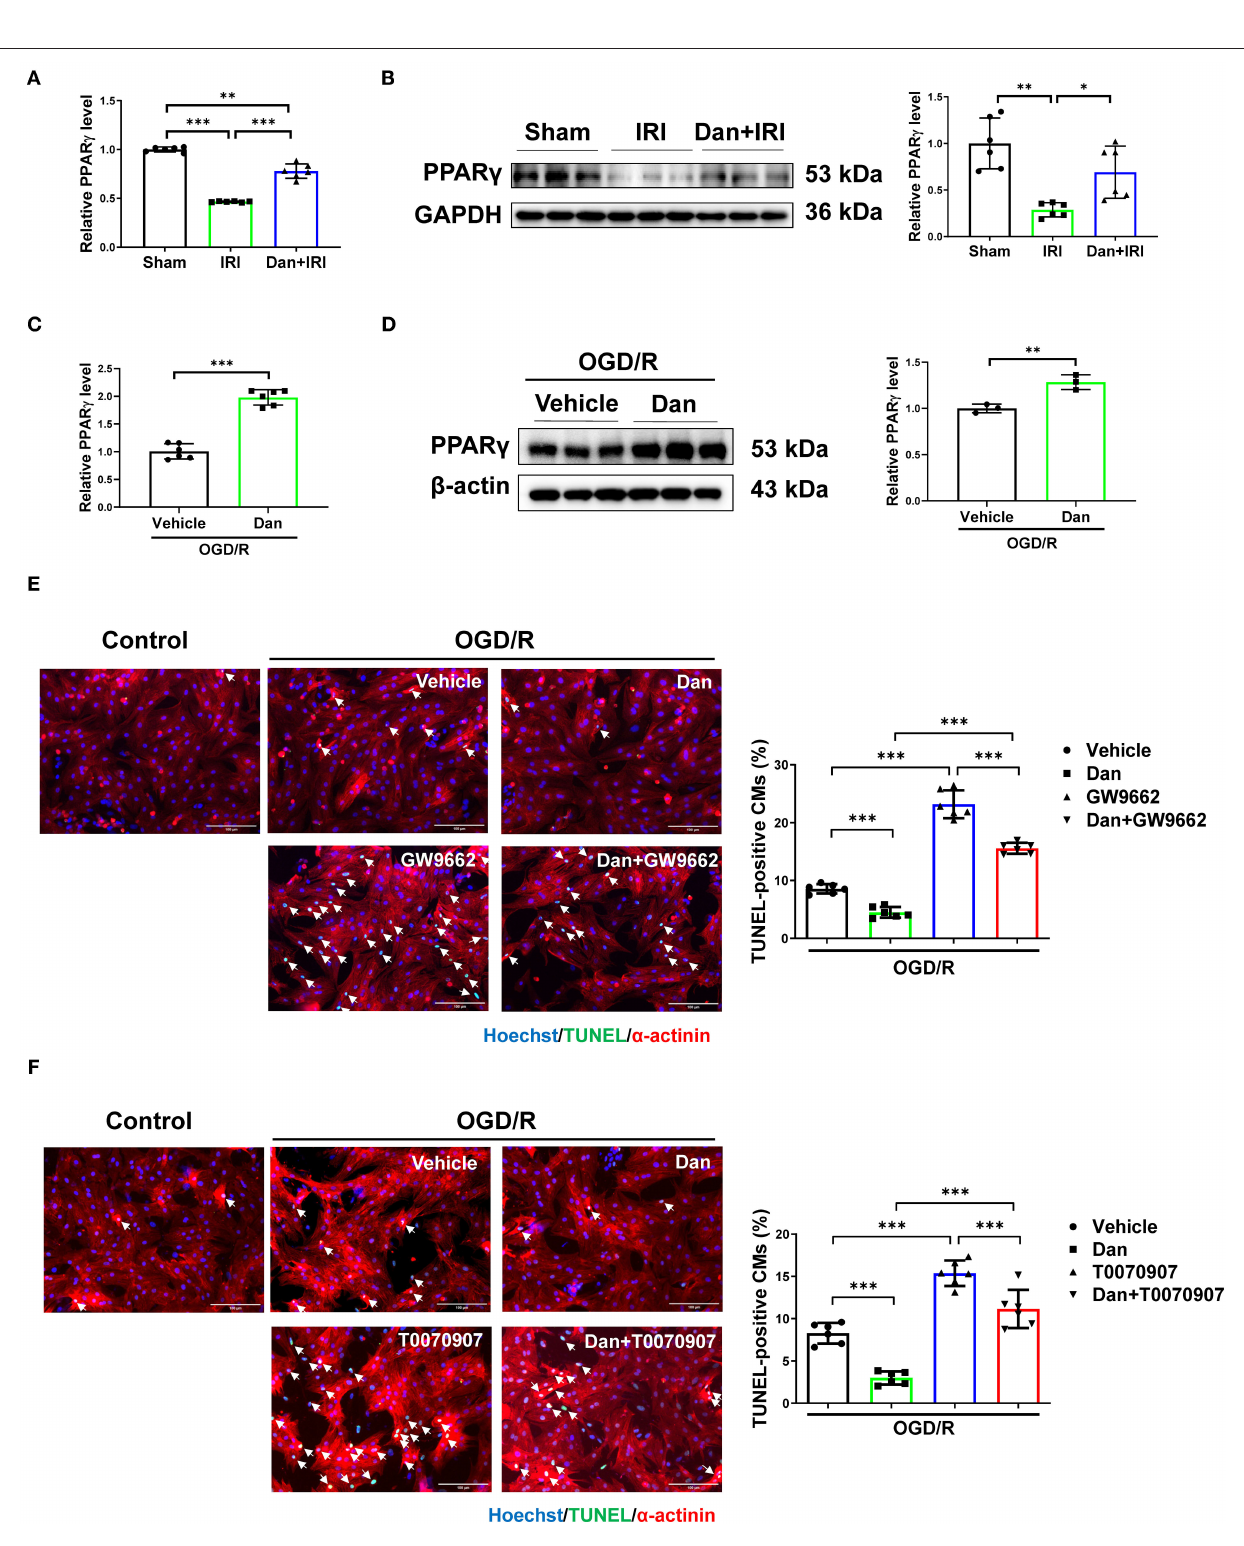
FIGURE 3 | Dan prevents CM apoptosis through activating PPAR γ in vitro . (A,B) RT-qPCR [ (A) , n = 6] and western blot [ (B) , n = 6] for PPAR γ in mice heart tissues of myocardial ischemia-reperfusion injury (IRI) in the presence or absence of Dan treatment. (C,D) RT-qPCR [ (C) , n = 6] and western blot [ (D) , n = 3] for PPAR γ in oxygen-glucose deprivation–reperfusion (OGD/R)-induced apoptosis of NRCMs in the presence or absence of Dan treatment. (E,F) TUNEL/ α -actinin staining for OGD/R-induced apoptosis of NRCMs treated with PPAR γ inhibitors, GW9662 (E) or T0070907 (F) , in the presence or absence of Dan treatment ( n = 6). Scale bar = 100 µ m. * p < 0.05; ** p < 0.01; *** p < 0.001.